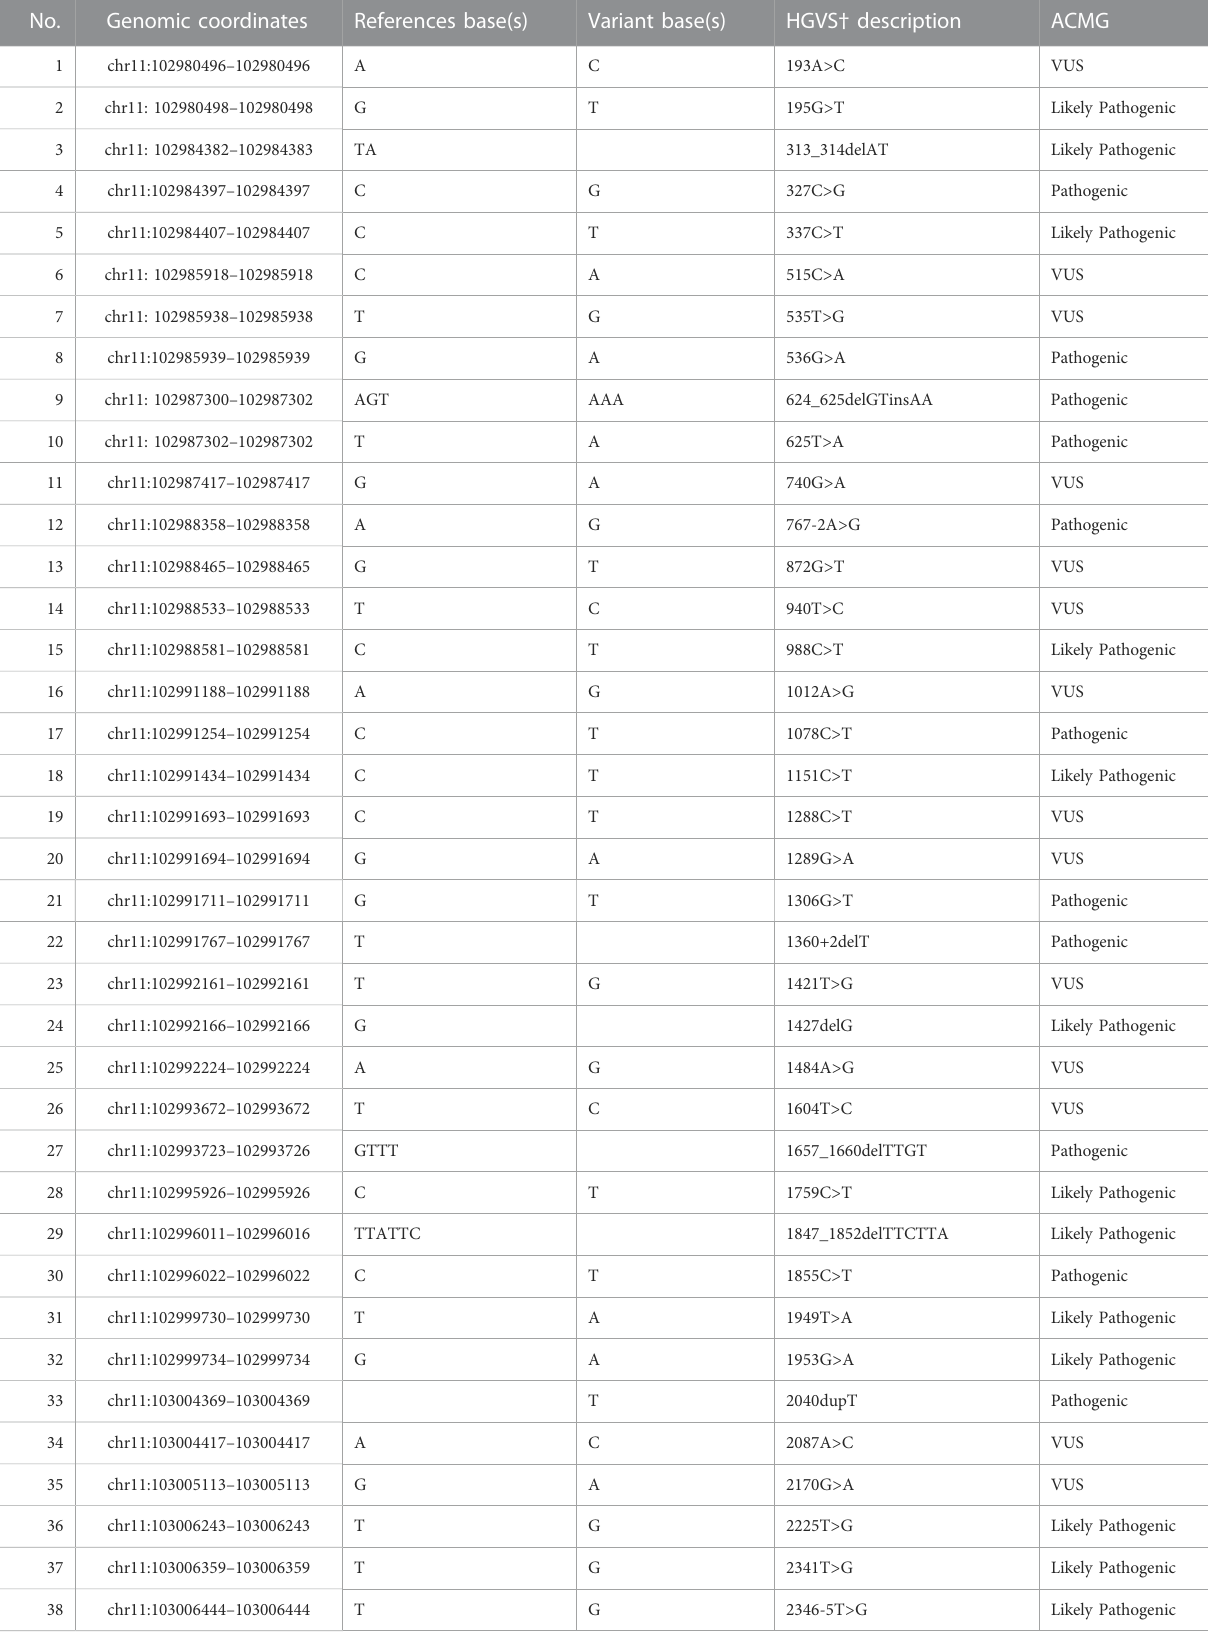
TABLE 2 DYNC2H1 variants (cited from HGMD † database, in order of mutation position).